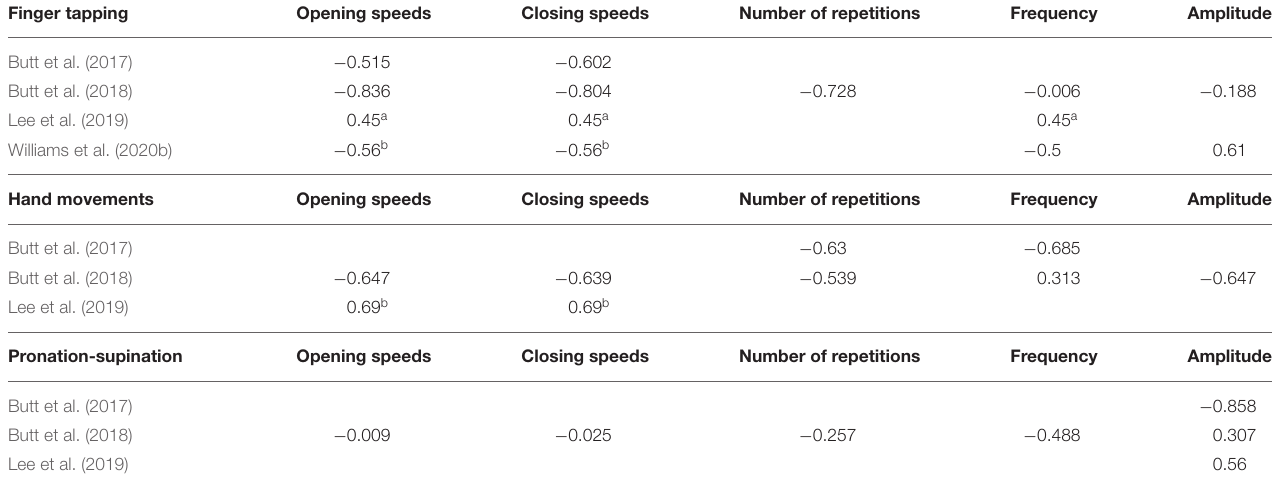
TABLE 5 | Correlation results for bradykinesia. Finger